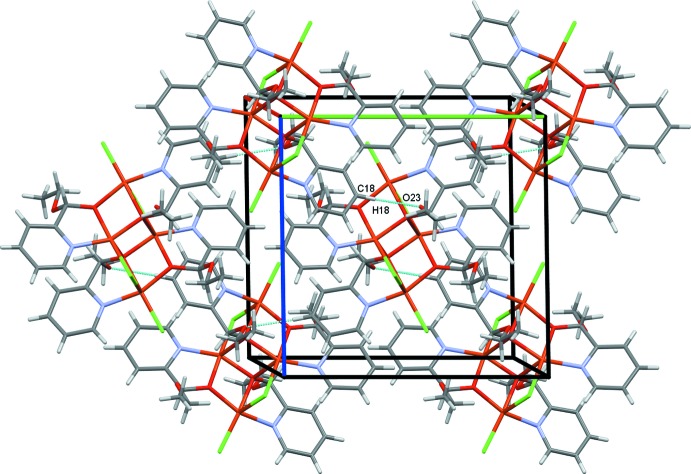
Two-dimensional sheet of mol­ecules of II along the bc diagonal.